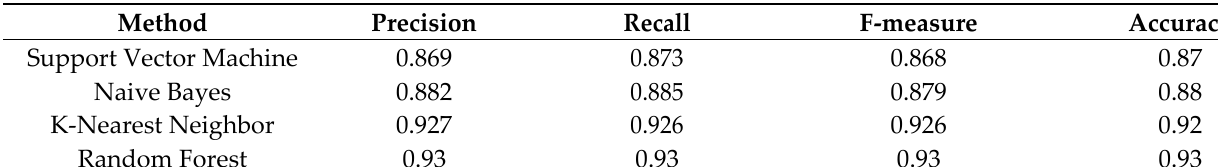
Table 2. COVID-19 classification results (10-fold cross-validation).